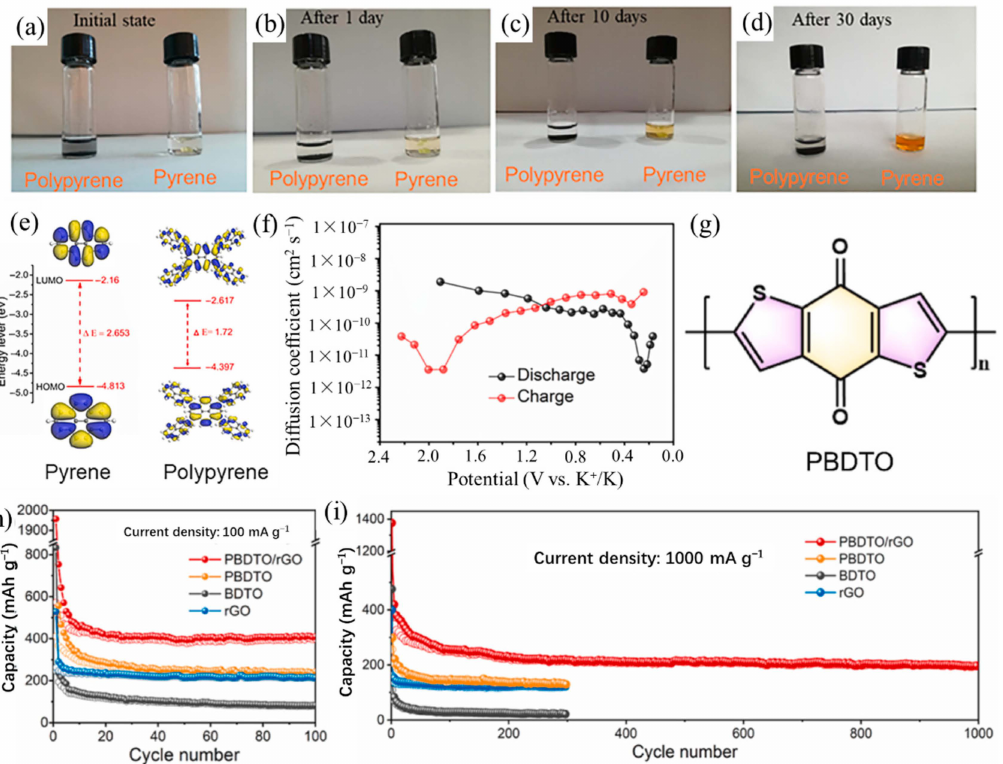
Figure 6. ( a – d ) Digital photos of the pyrene and polypyrene dispersed in the electrolyte of KIBs for different time intervals. ( e ) Theoretical calculated HOMO and LUMO in optimized structures of pyrene and polypyrene. ( f ) Diffusion coefficients at different potentials during potassiation and depotassiation of polypyrene. ( a – f ) Reproduced with permission from Ref. [63]. Copyright 2021 Elsevier B.V. ( g ) The molecular structure of PBDTO. Cycling performance (h) at 100 mA/g and (i) at 1000 mA/g of PBDTO/rGO, PBDTO, BDTO, and rGO. ( g – i ) Reproduced with permission from Ref. [64]. Copyright 2022 Elsevier